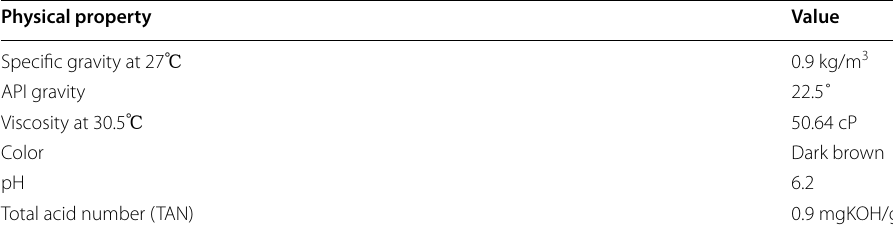
Table 3 Physical properties of crude oil sample